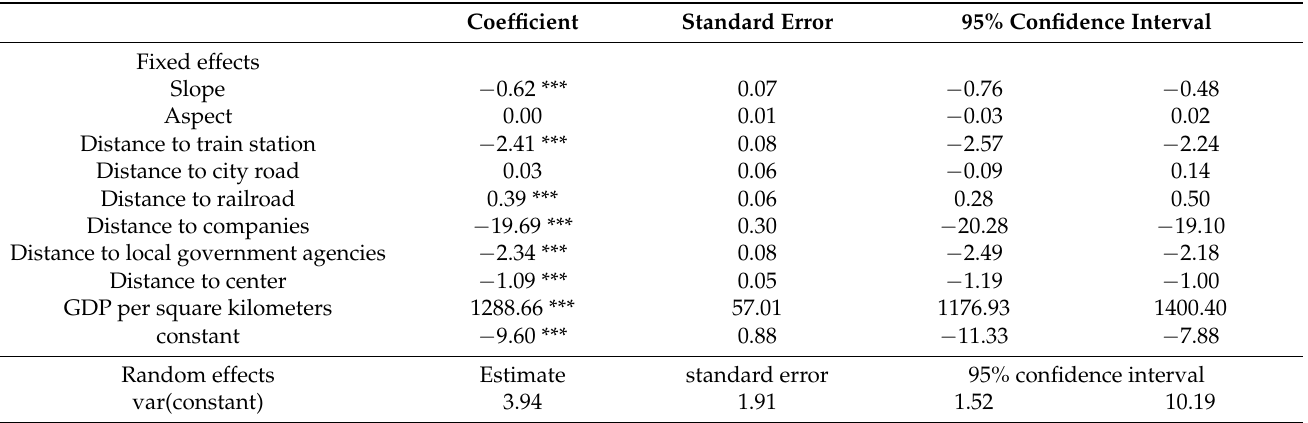
Table 3. Results of multi-level logit